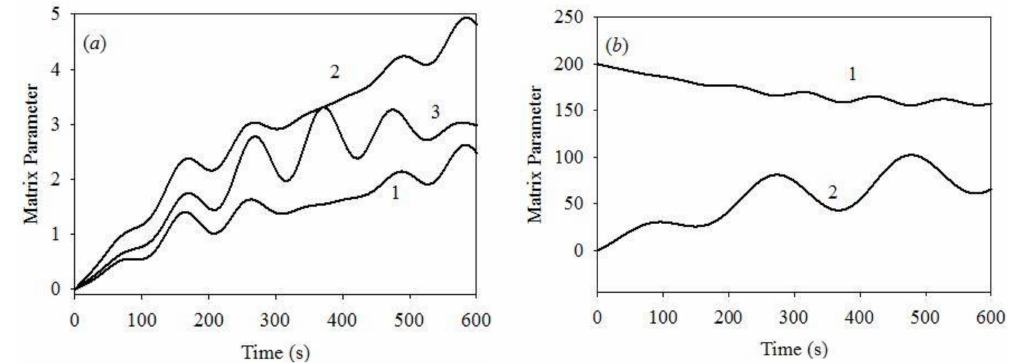
(cid:17) (cid:17) (cid:16)(cid:16) × 5 − 0.5 C in , µ M; (2) [K + ], Ca 2 +